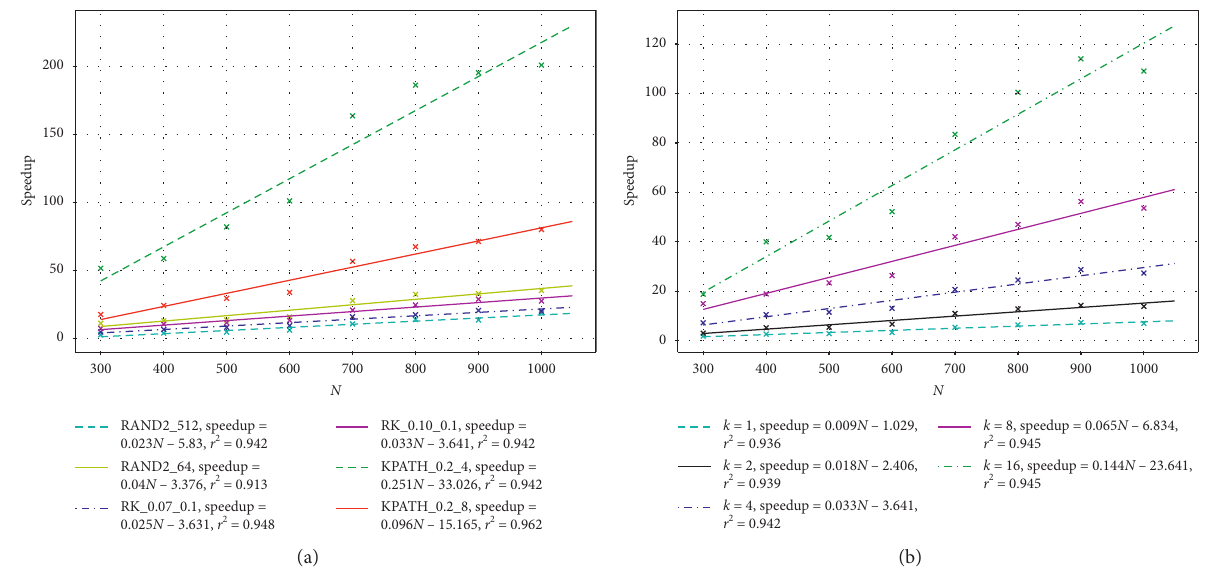
Figure 12: Speedups of different betweenness approximation algorithms with k � 4 (a) and speedups with increasing k using RK_0.10_0.1